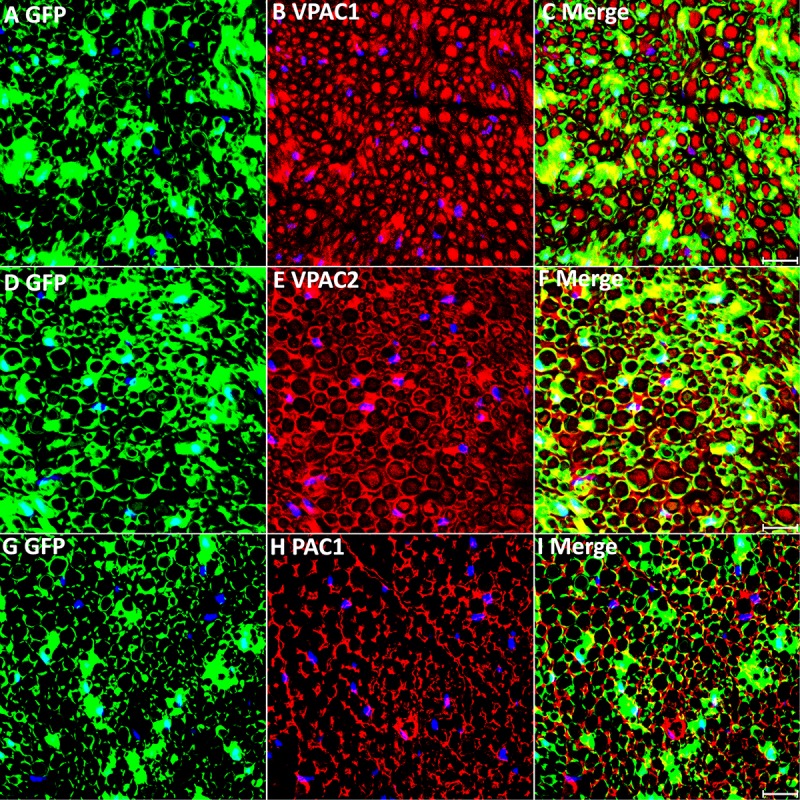
VPAC1, VPAC2, and PAC1 staining on transverse sections from uninjured sciatic nerve of PLP-GFP mice. VPAC1 (A–C), VPAC2 (D–F), and PAC1 (G–I) staining all co-localize with GFP-positive Schwann cells. VPAC1 and VPAC2 also show positive staining in axons but PAC1 (G–I) does not. Scale bars in (C,F,I) 20 μm. Three mice were used and three sections from each mouse were stained for each receptor.